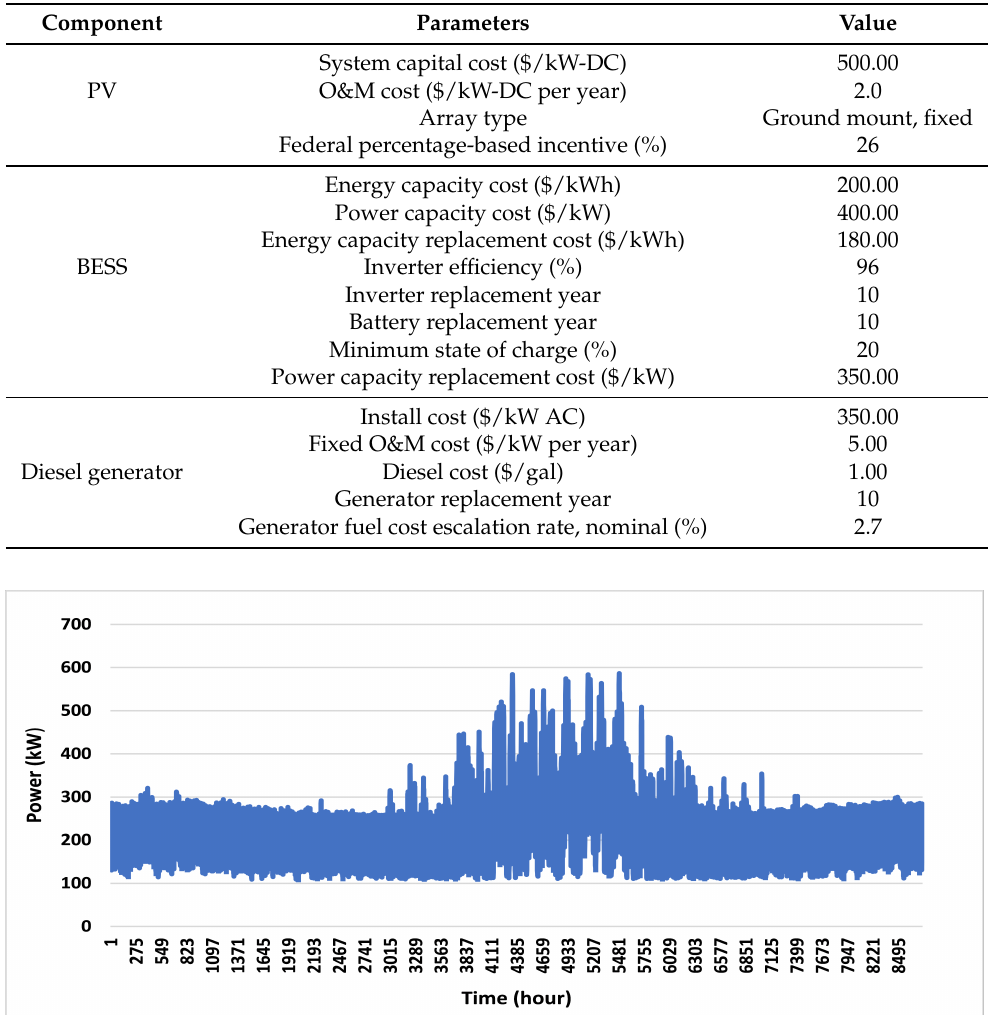
Figure 7. Hourly load profile during a